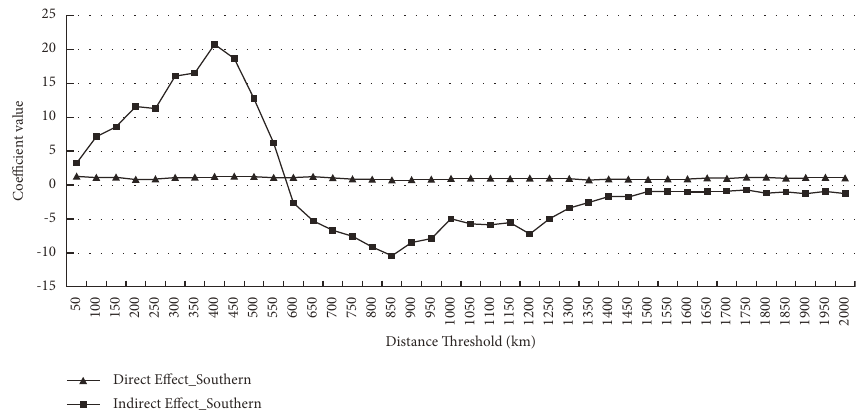
Figure 11: Spatial trends of the impact of the southern region’s digital economy on urban innovation.